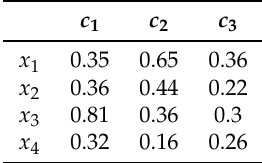
Table 11. R 3 : opinion of expert m 3 .